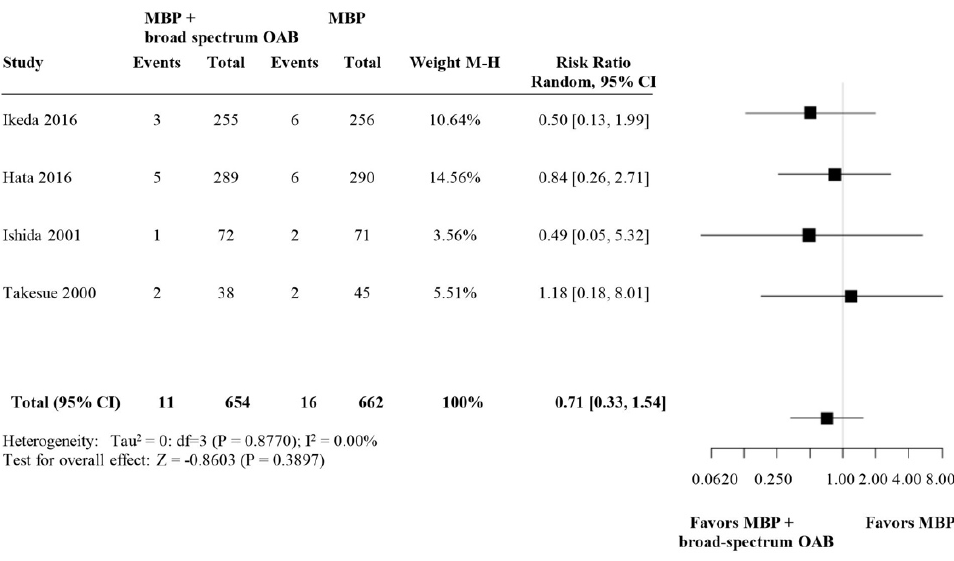
Figure 5. Forest plot comparing anastomotic leakage rate for patients receiving broad-spectrum OABs (defined as OABs that are effective against both aerobe and anaerobe bacteria) in addition to MBP and i.v. antibiotic prophylaxis versus MBP alone with i.v. antibiotic prophylaxis. A random effects model was used to perform the meta-analysis and risk ratios are quoted including 95% confidence intervals. In the subgroup analysis, a significant reduction of SSI in both variants of OAB regimes was seen; SDD (RR 0.21, 95% CI (0.09–0.49) compared to broad-spectrum antibiotics (RR 0.58, 95% CI (0.37–0.91) (Figures 6 and 7 respectively).